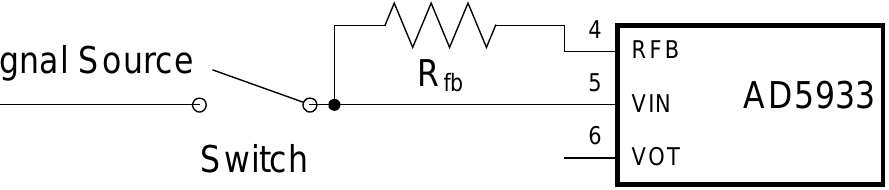
Figure 8. Simplified schematic for eliminating AD5933 internal DC leakage from AC signal: internal DC offset is processed by the on-chip circuitry and recorded when the switch is open.